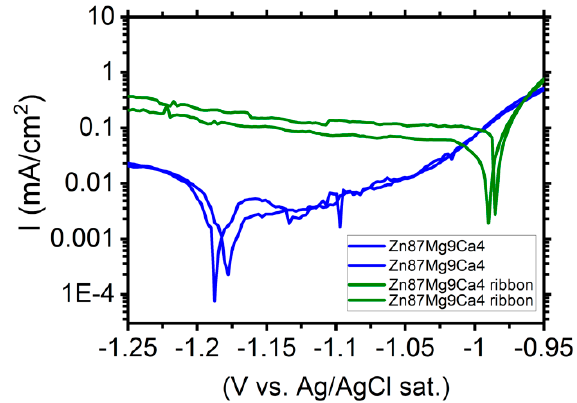
Figure 11. Polarization curves performed for Zn 87 Mg 9 Ca 4 bulk material samples (blue curves) and Zn 87 Mg 9 Ca 4 ribbons (olive curves) in Ringer’s solution at 37 ° C, pH 7.2.